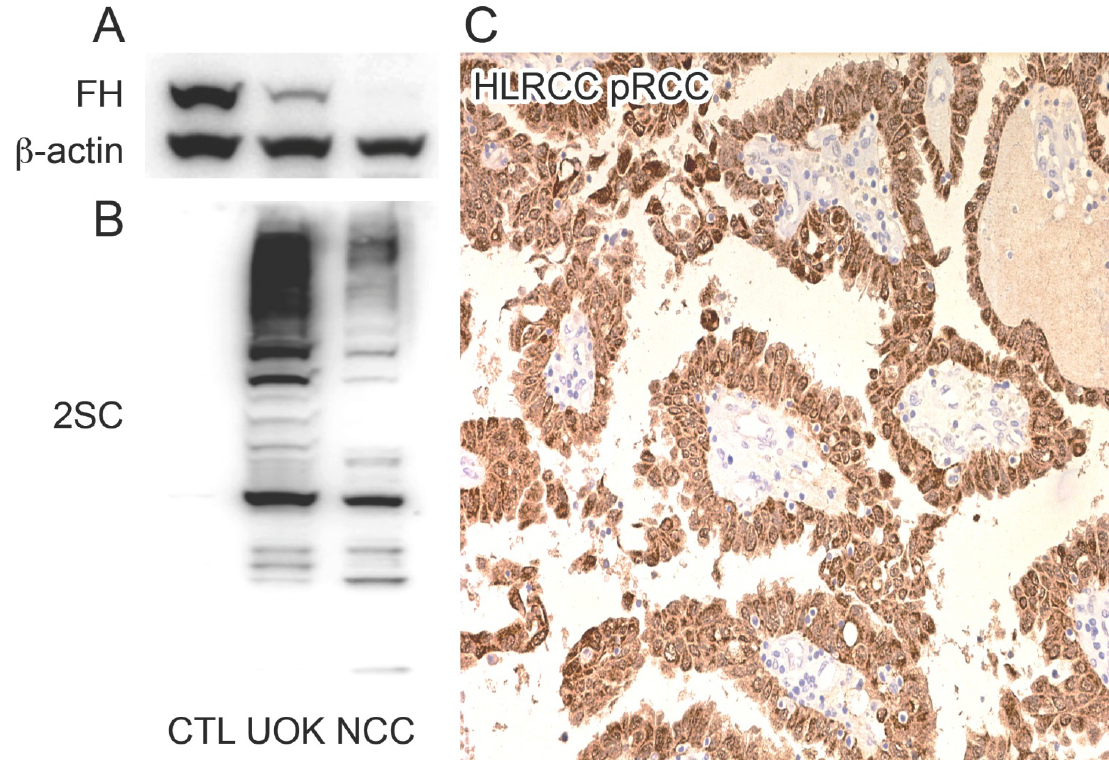
Figure 1. Hereditary leiomyomatosis and renal cell cancer (HLRCC) tumours and tumour-derived cell lines express high levels of 2SC. ( A ) Immunoblotting confirms the presence of fumarate hydratase (FH) in the control human renal proximal tubular epithelial (RPTC) cell line (CTL), the presence of the mutant FH allele in the UOK262 (UOK) HLRCC-derived cell line as previously described and absence of FH protein in the NCC- FH-1 (NCC) HLRCC-derived cell line. β -actin levels were used as a loading control for each cell line. ( B ) Immunoblotting for 2SC clearly shows an absence of 2SC expression in the control cell line but high expression of 2SC in the FH-mutant cell lines (UOK and NCC). ( C ) Positive 2SC immunoreactivity (indicated by brown staining) is evident in the tumour cells of an FH mutant type 2 PRCC (HLRCC PRCC) but absent in the stromal tissue (blue